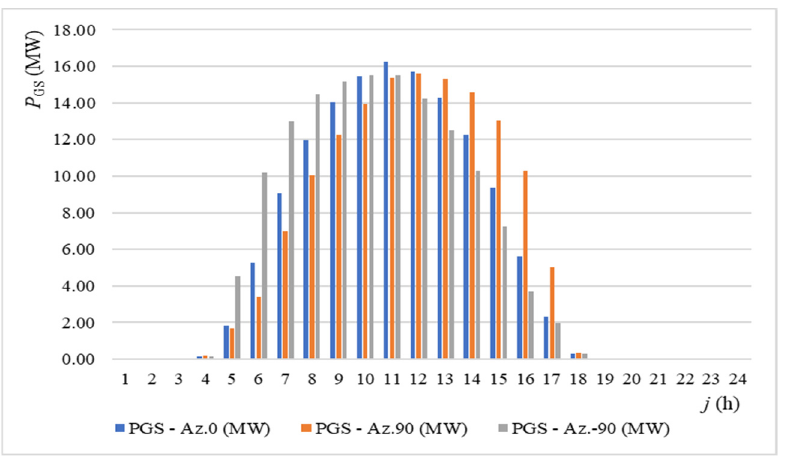
Figure 8. Daily output power of the SPP for case 2.